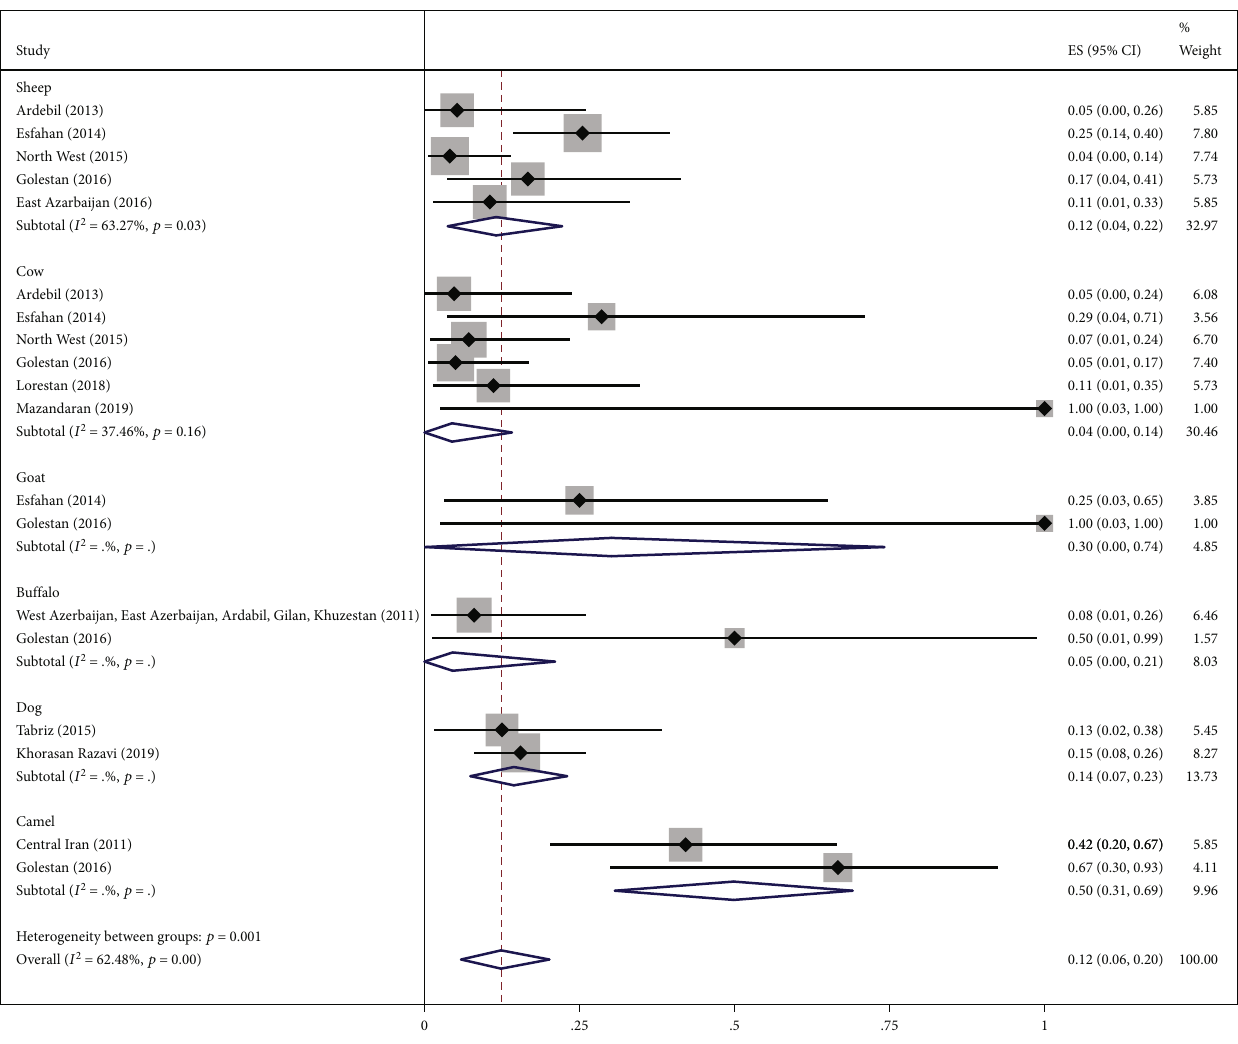
prevalence by animal 3